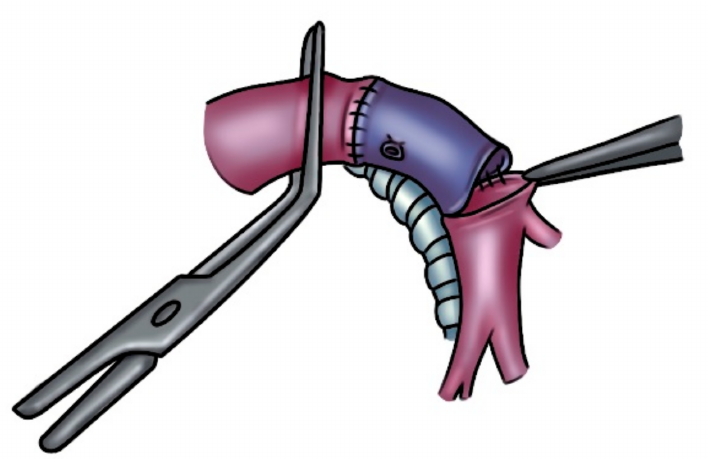
Figure 6. Left PA reconstruction with an autologous pulmonary vein conduit (proximal and distal